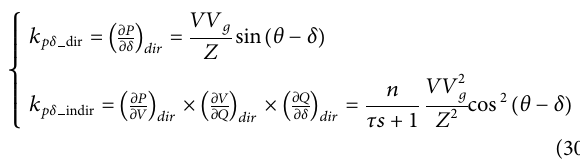
Frontiers in Energy